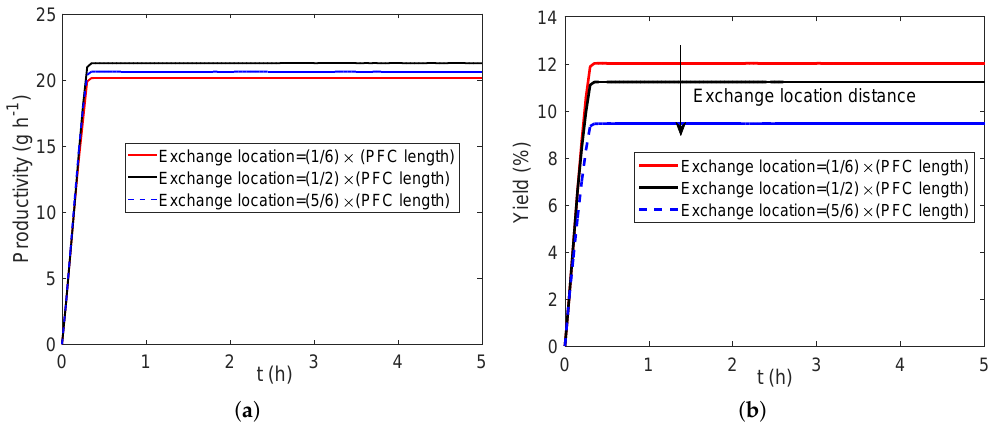
Figure 6. ( a ) Effect of the liquid phase exchange location on the productivity (exchange fraction = 0.5). Productivity is the highest for the process condition considered when the exchange location is at the midpoint along the length of the PFC. ( b ) Effect of the liquid phase exchange location on the yield in the PFC (exchange fraction = 0.5). Yield follows a trend that it is largest corresponding to the process conditions used when exchange location is at 1/6 × PFC length and then gradually decreases as the length of the exchange location increased.